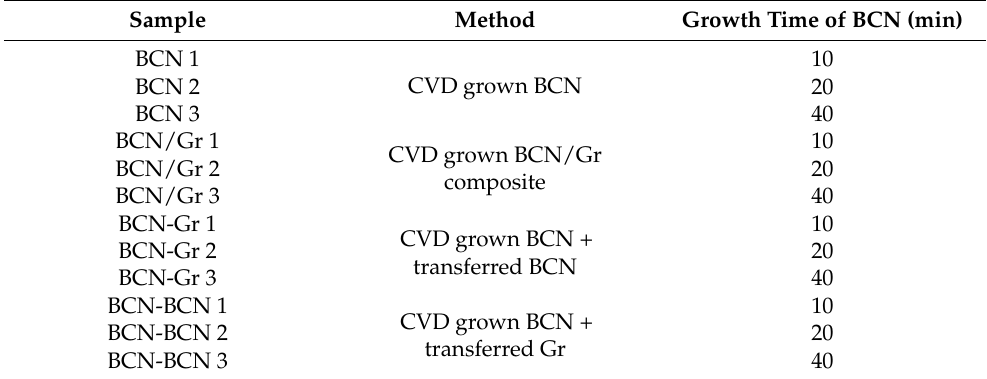
Table 1. Samples prepared in this